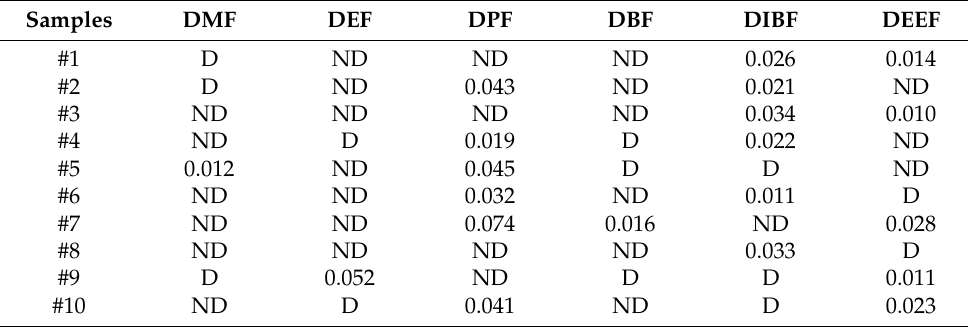
Table 2. Concentration of investigated phthalates in bottled water ( µ g/mL). Samples